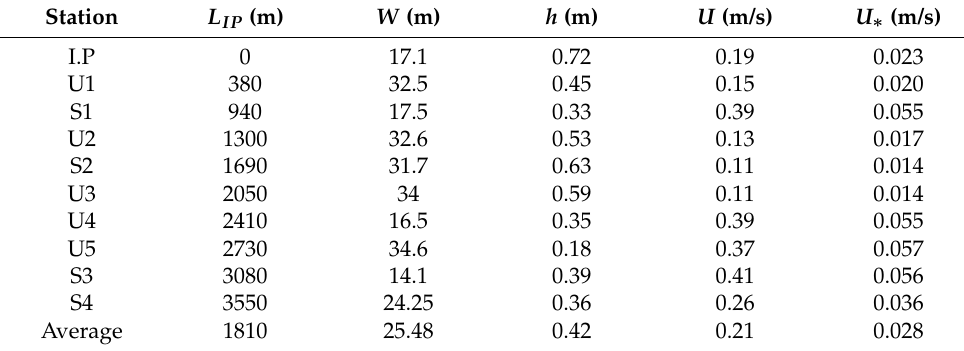
Table 4. Measured hydromorphic properties in Cheongmi Creek